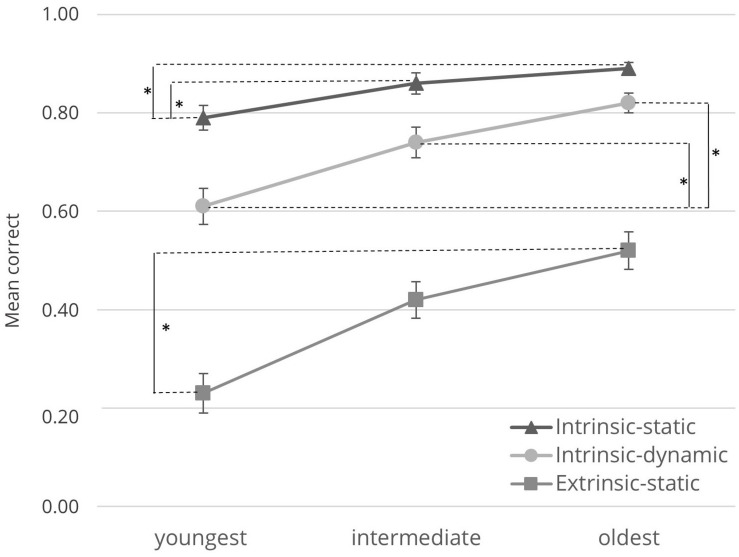
Task performance for each age group. M (Mean Correct) for all three sub-groups for the tested abilities (black, intrinsic-static VSA; light-gray, intrinsic-dynamic VSA; gray, extrinsic-static VSA). Error bars reflect 1 SE. Significant differences with p < 0.05, as indicated by the asterisk (*).